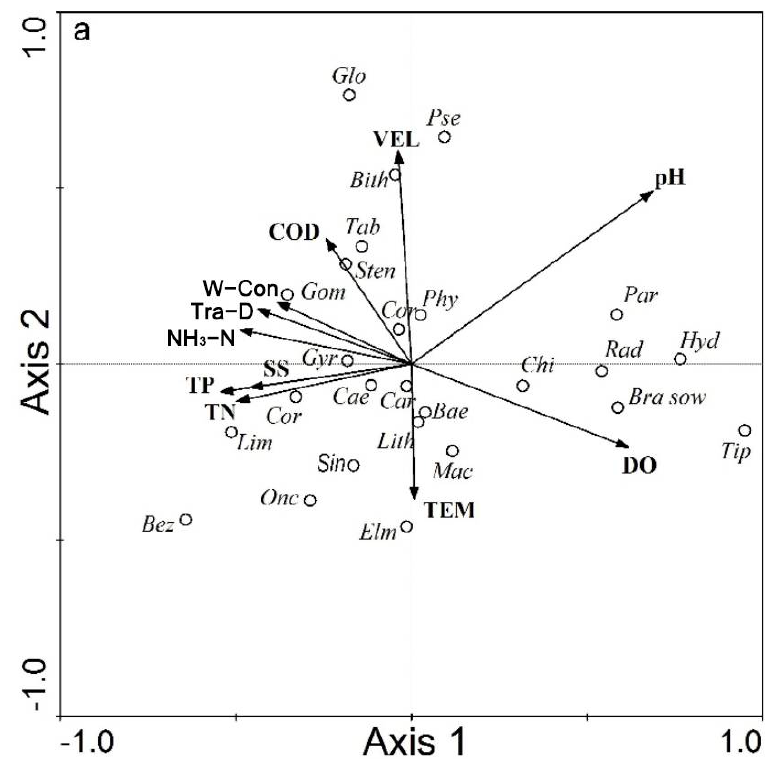
Figure 5. Ordination of macroinvertebrate abundance with environmental variables using canonical correspondence analysis. Significant environmental variables are represented by arrows. Abbrevia- tions are spelled-out in Tables 1 and 2. Tra-D, traffic density; W-Con, construction phase; open circles, abundance of macroinvertebrates.